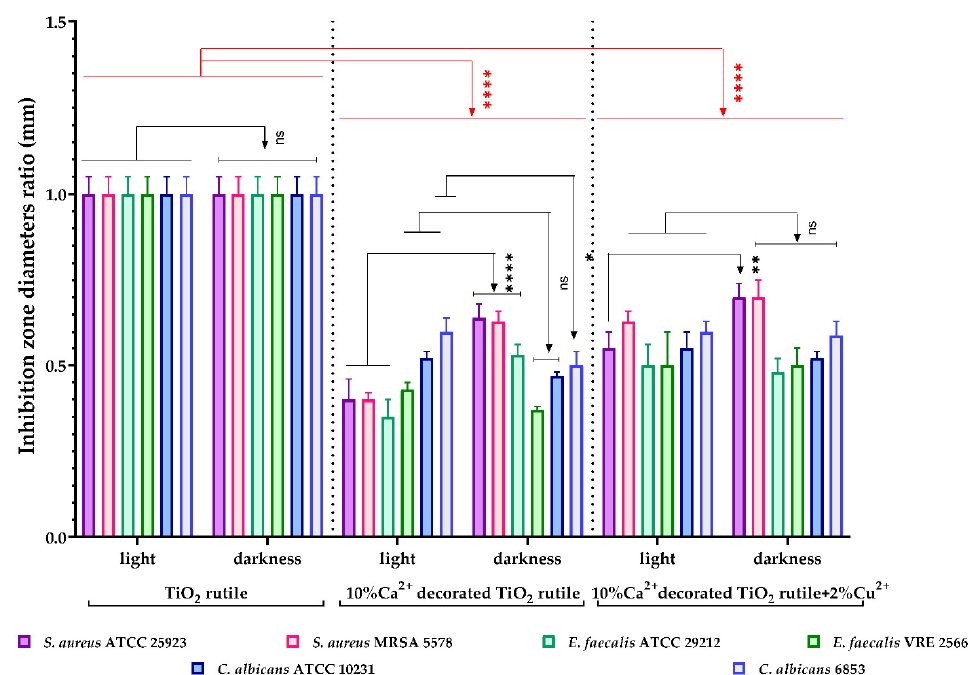
Figure 10. Graphic representation of the inhibition zone diameters expressed as the diameter ratio, obtained for the tested C. albicans and Gram-positive strains, after incubation in two different conditions: visible light and darkness. The results were compared using two-way ANOVA and Dunnett’s multiple comparisons tests; ns—not significant; * p < 0.05; ** p < 0.003; **** p < 0.0001. The antimicrobial activity of the tested samples was quantitatively evaluated by cov-